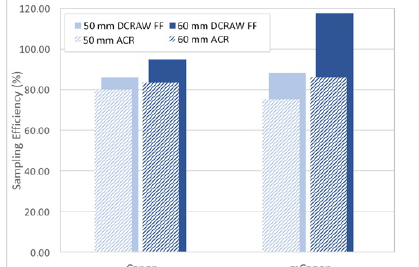
Figure 9. Sampling efficiency (%) of the unmodified (‘Canon’) and modified (‘mCanon’) cameras with the Canon 50 mm (‘50’) and the Coastal Optics 60 mm (‘60’) lenses. The image processing included ACR (‘ACR’) and DCRAW with flat field correction, scaling, and gamma correction (‘DCRAW